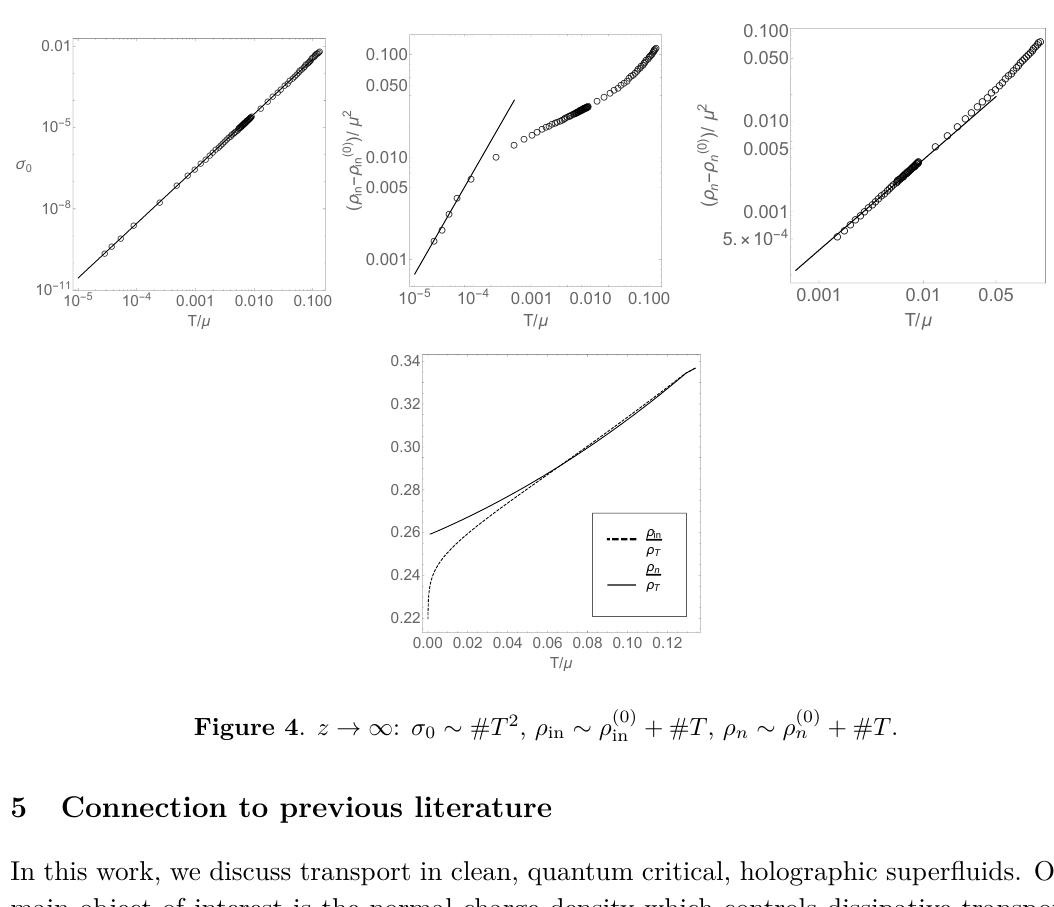
Figure 4 . z → ∞ : σ 0 ∼ # T 2 , ρ in ∼ ρ (0)